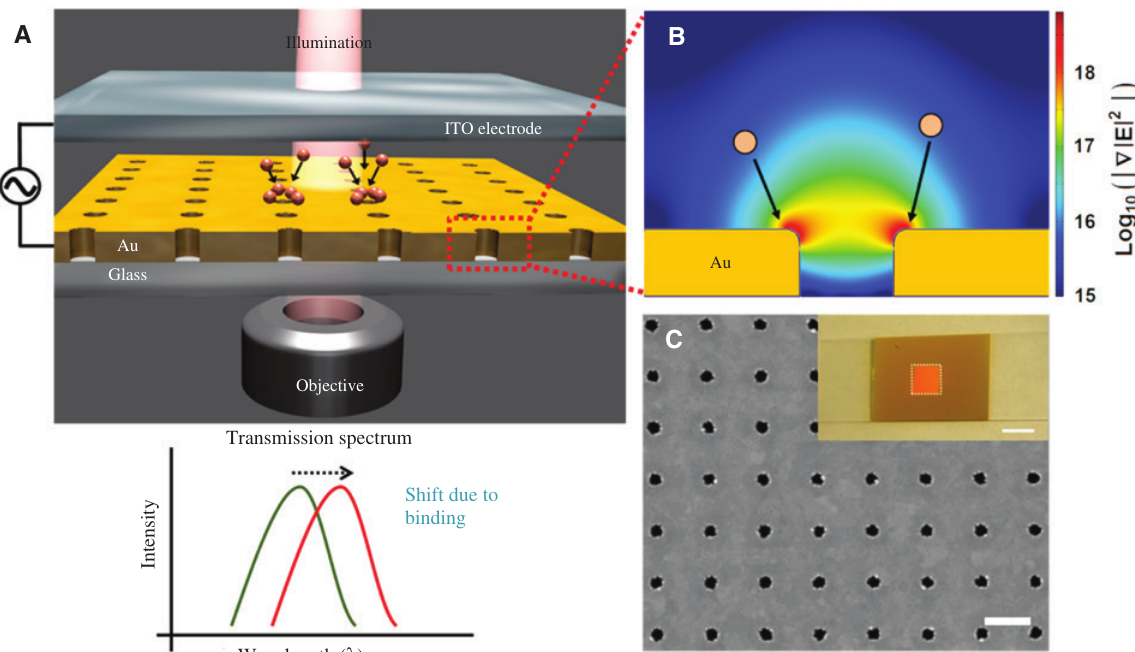
Figure 3: (A) Illustration of the setup used for the dielectrophoretic concentration of analyte molecules. Upon applying appropriate bias between the upper ITO electrode and gold nanohole array, analyte molecules got attracted toward the gold surface. In the setup, a tungsten- halogen lamp was used to illuminate the setup, and the light transmitted through the nanohole array was collected. Because of analyte binding, the transmission spectrum related to the SPs at the interface of gold-water shifted toward longer wavelengths due to changes at the interfacial RI. (B) Analyte molecules were attracted toward the hole edges, where the electric field with strongest intensity gradient existed (red color) along the rims of the holes. (C) SEM image of the nanohole array was used to measure the hole diameters: hole diameter and periodicity were 140 and 600 nm, respectively. Scale bar is 500 nm. Inset: photograph of the template-stripped gold nanohole array. Scale bar is 0.5 μ m (scale bar in inset image is 1 cm). Adapted from Ref. [120]; American Chemical